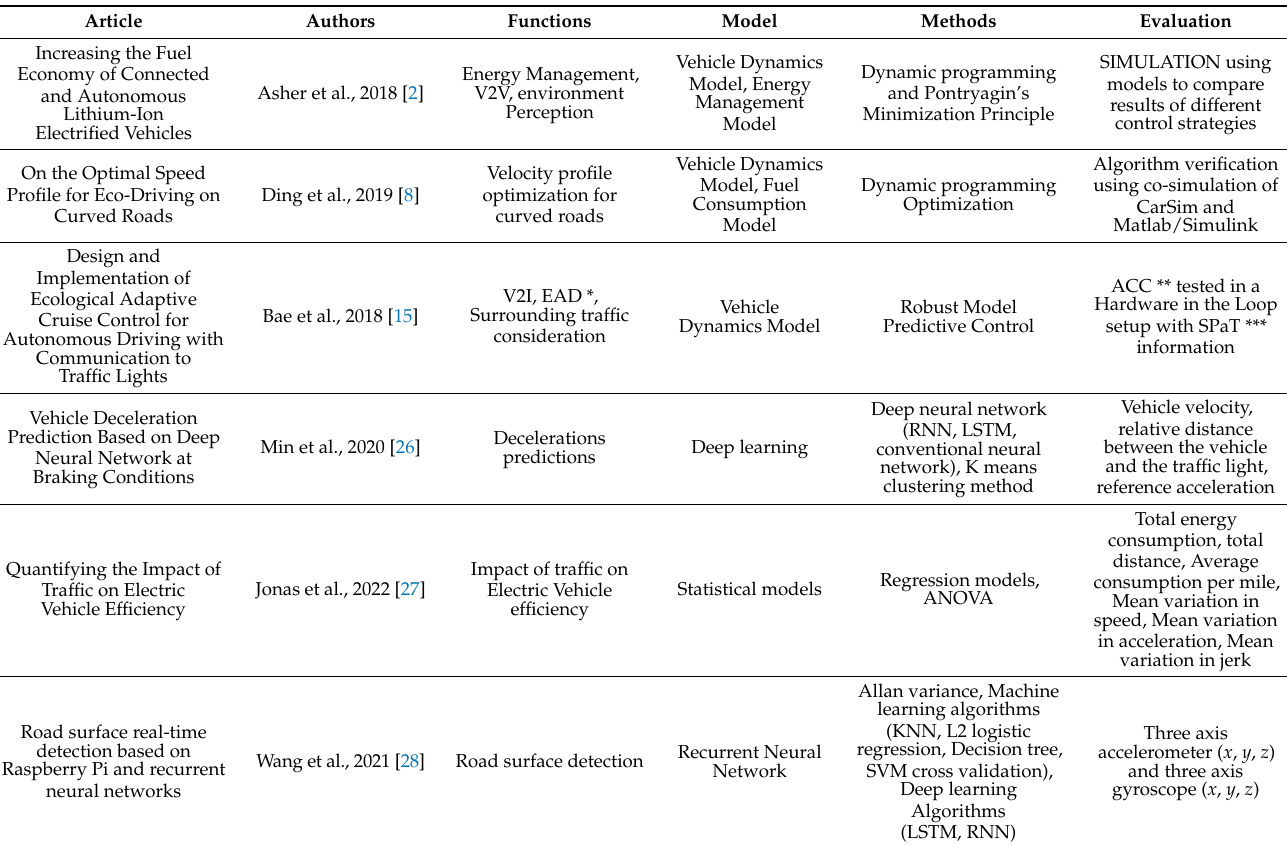
Table 1. State-of-the-art